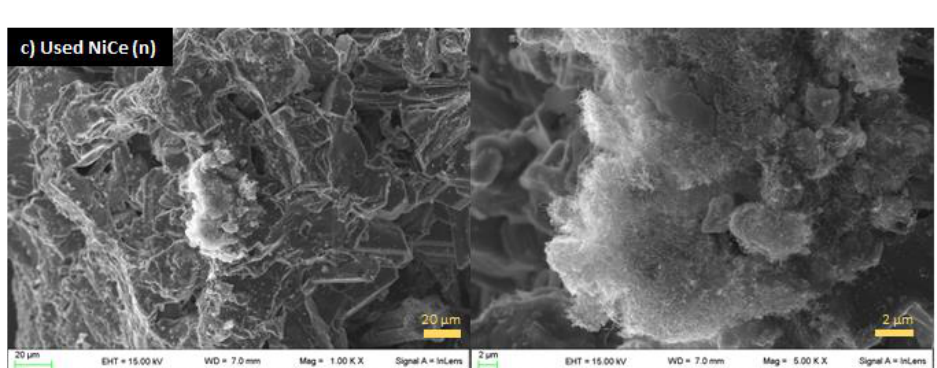
Figure 8. Carbon Mapping and EDX spectra of spent catalysts: ( a ) used NiCe (i); ( b ) used NiCe (c); ( c ) used NiCe (n).